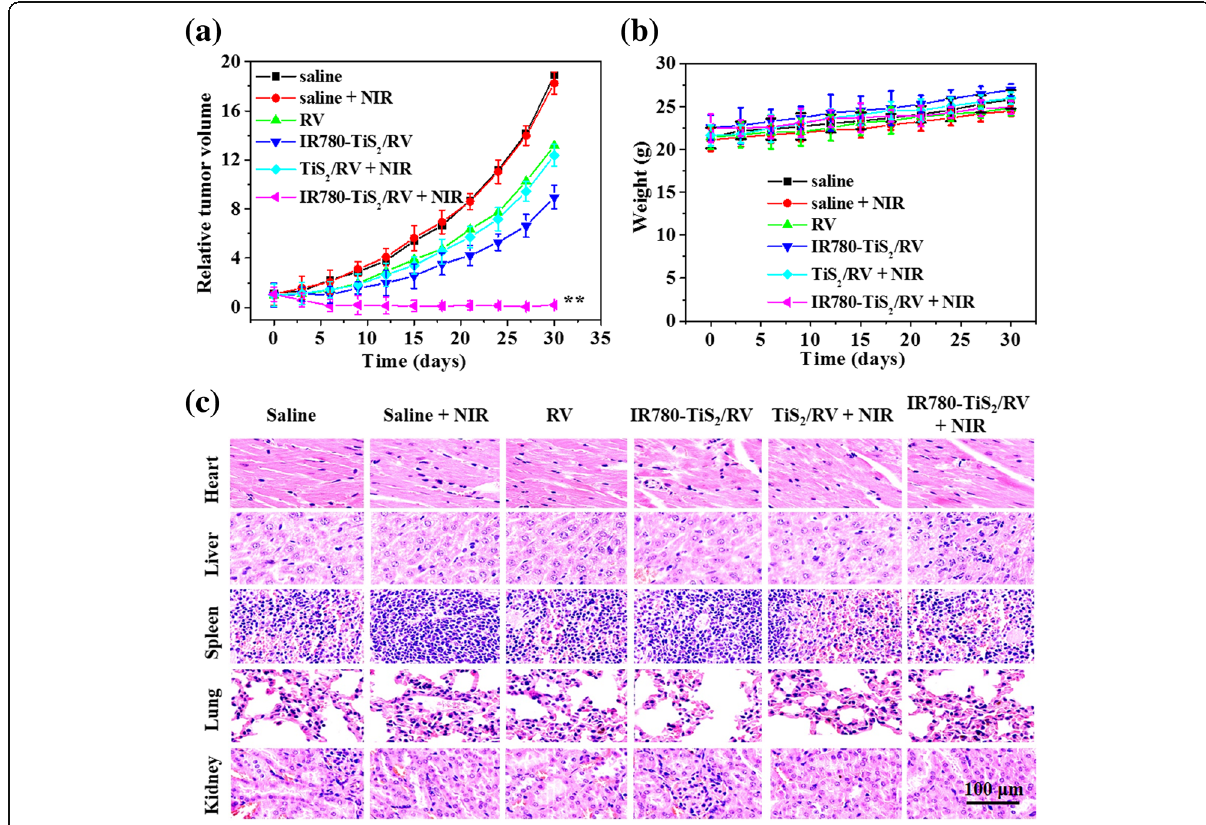
Fig. 6 a The growth profile of CT26 xenografted tumors after intravenous injection of saline (control), RV, TiS 2 /RV, and IR780-TiS 2 /RV with or without a 3-min NIR irradiation (808 nm, 0.3 W/cm 2 ). b Body weight of tumor-bearing mice after various treatments. c H&E images of major organs of all treated mice after 30 days of treatment. **P < 0.01, compared with saline, saline + NIR, RV, TiS 2 /RV + NIR, and IR780-TiS 2 /RV